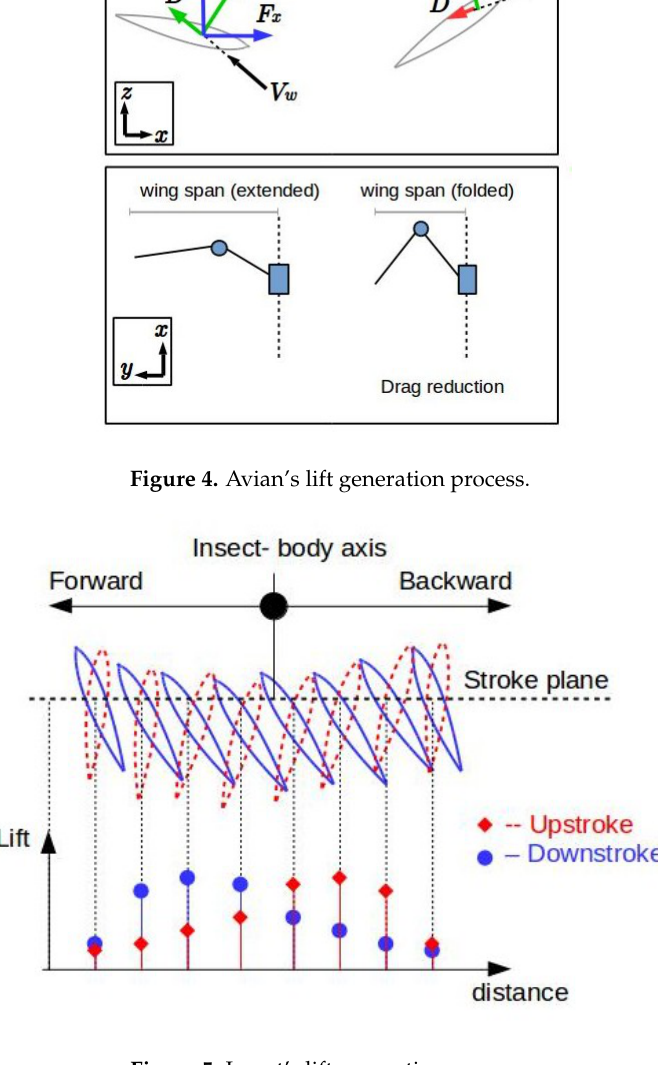
Figure 5. Insect’s lift generation